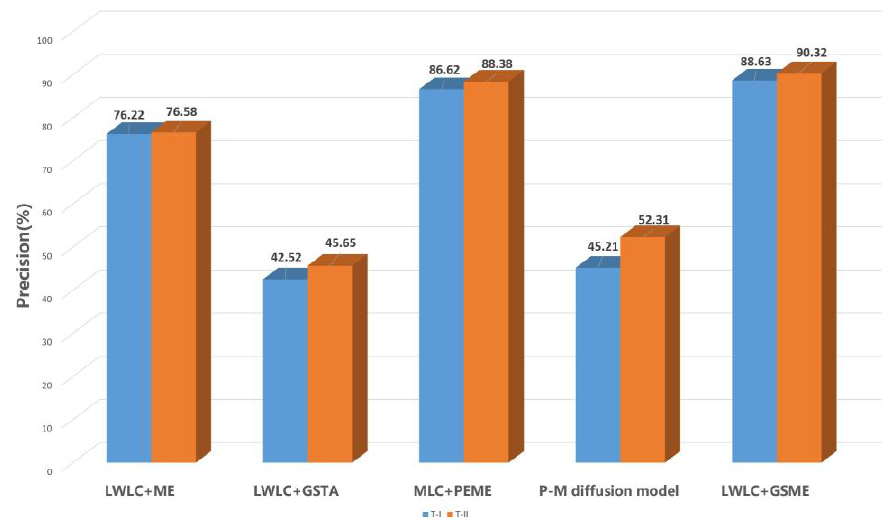
Figure 12. Comparison of defection precision for four detection methods. The blue block and orange block denotes T-I defect and T-II defect, respectively.